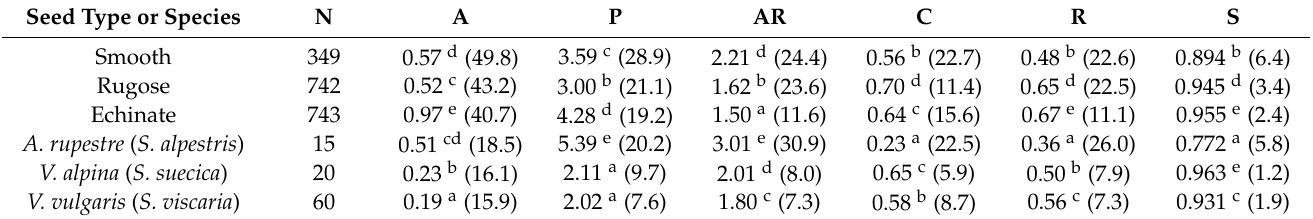
Table 4. Results of Kruskal–Wallis and post hoc tests for the dorsal views of seeds in the three groups of Silene species (smooth, rugose and echinate) and for species Atocion rupestre , Viscaria alpina and Viscaria vulgaris . Mean values and coefficients of variation (given in parentheses) are indicated for area (A), perimeter (P), aspect ratio (AR), circularity (C), roundness (R) and solidity (S). Values marked with the same superscript letter in each column correspond to populations that do not differ significantly at p < 0.05 (Campbell and Skillings’s test). N indicates the number of seeds